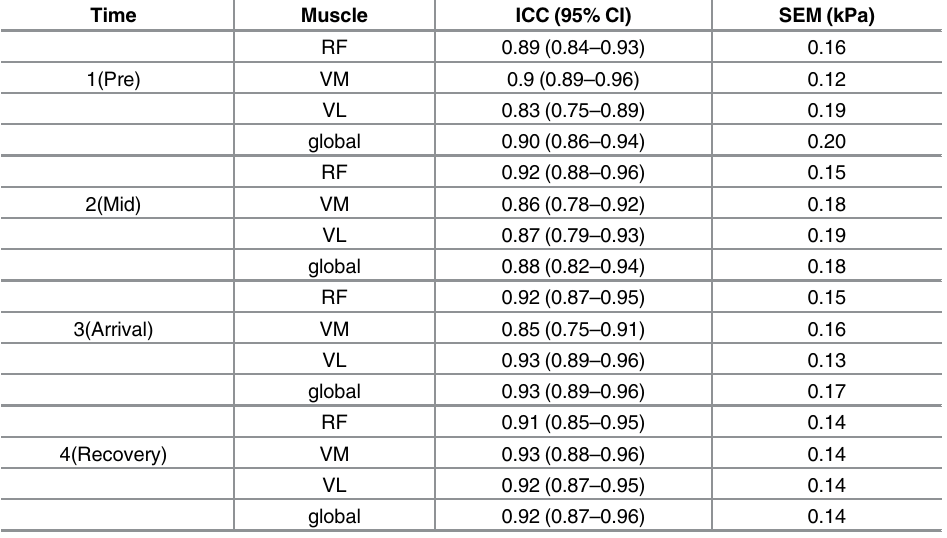
Table 2. Relative (intraclass coefficient) and absolute (standard error of measurement) shear modu- lus ( μ )